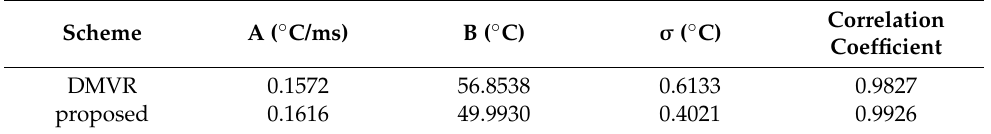
Table 2. Parameters of the regression curve T = A · t + B